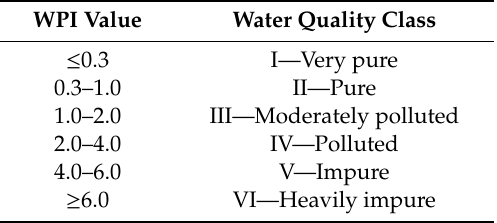
Table 4. Water quality classification based on the Water Pollution Index (WPI).